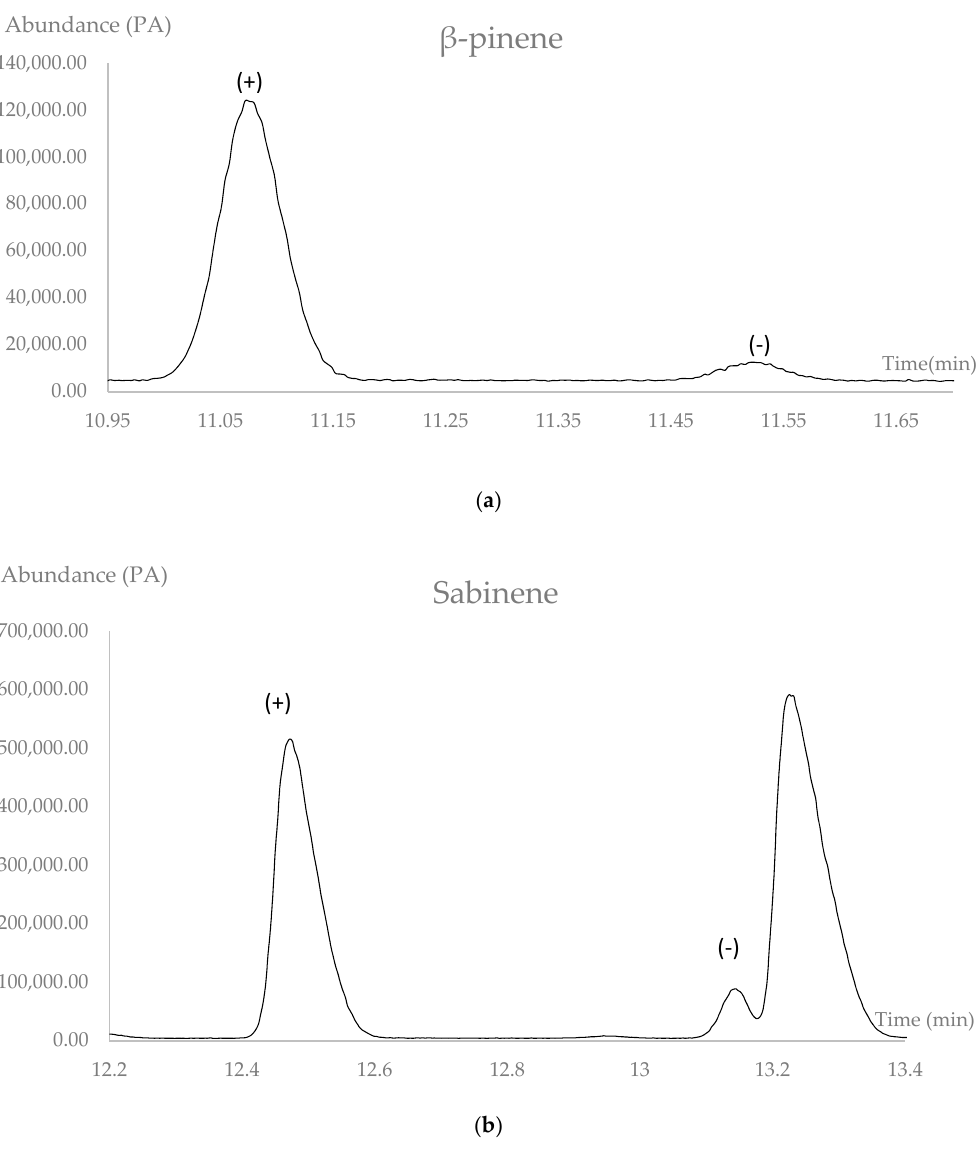
Figure 3. Enantiomeric separation in the essential oil Niphogeton dissecta : ( a ) β -pinene; ( b )